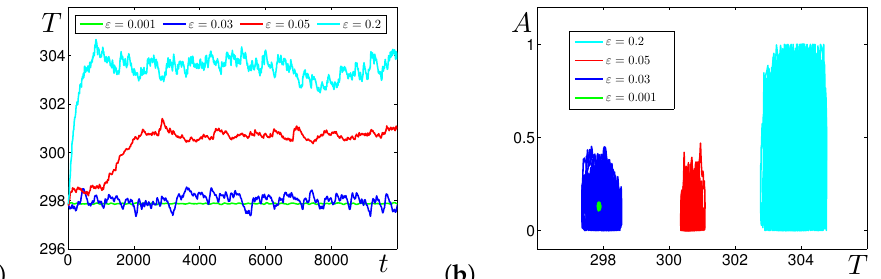
Figure 2. Stochastic system (2), (3) for γ = 0.1, σ 1 = 0, σ 2 = 1: ( a ) time series, ( b ) phase